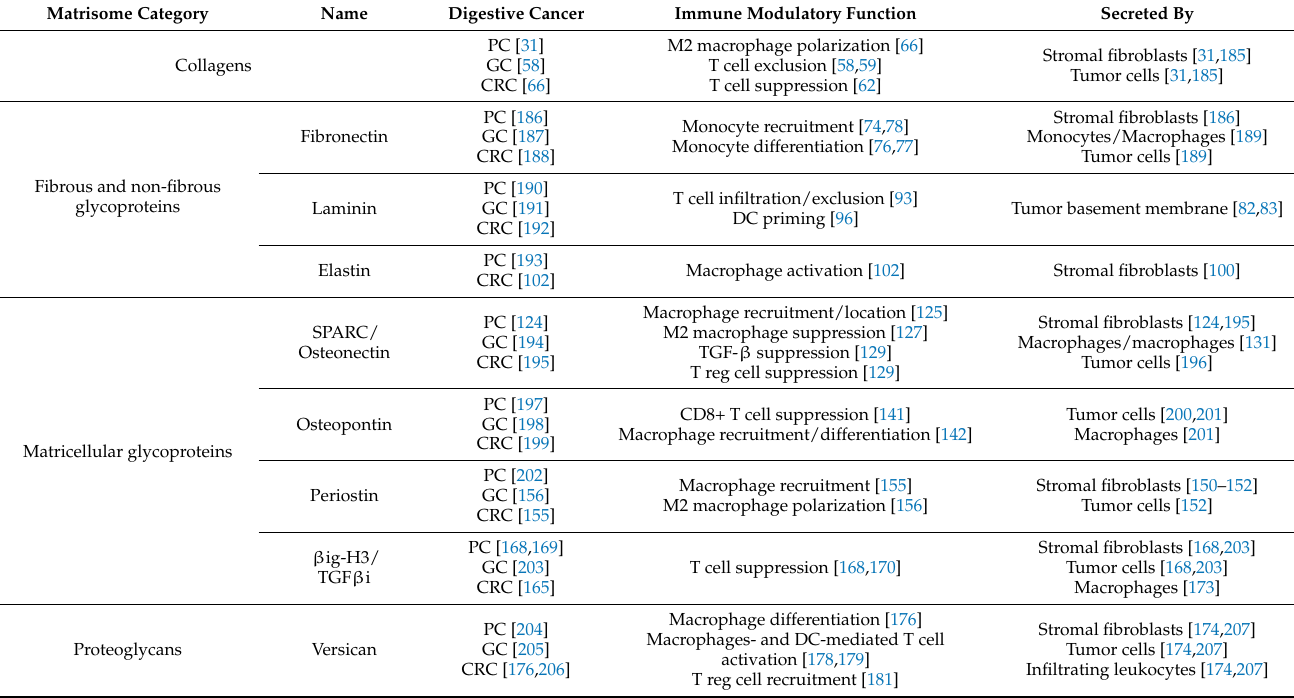
Table 1. ECM proteins with immune modulatory functions in colorectal (CRC), gastric (GC) and pancreatic cancer (PC). Matrisome